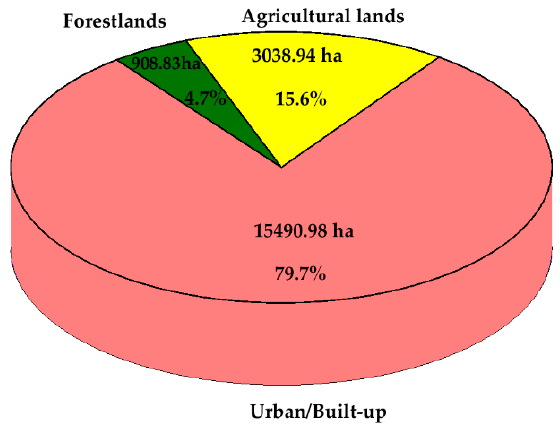
Figure 6. Projected LULC distribution for 2025.